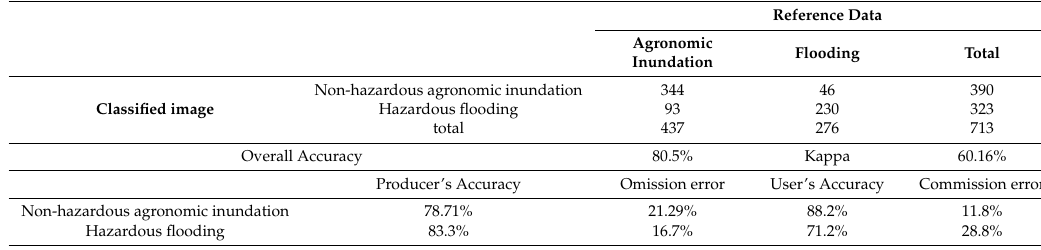
Table 5. Confusion matrix of rice fields with flooding derived using EVI40 based on respondents’ reports on flood locations during the wet planting season